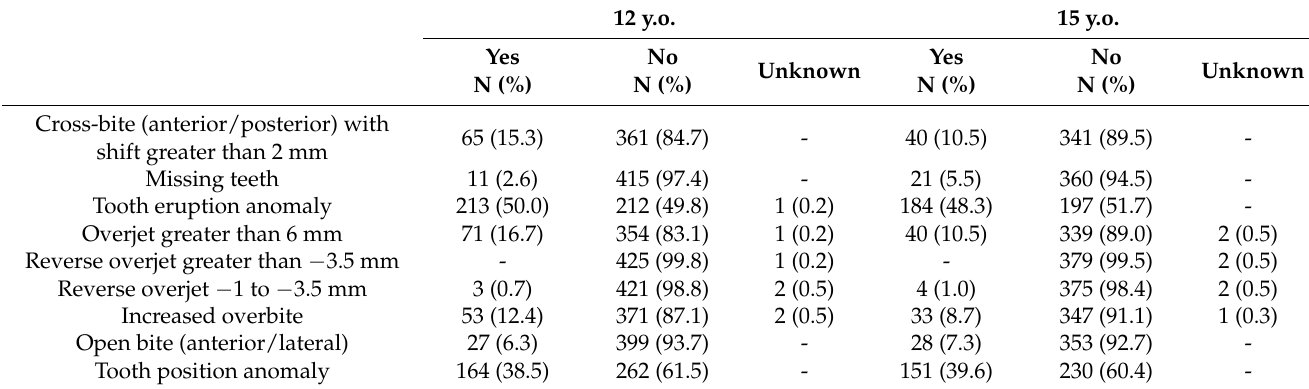
Table 8. Distribution of occlusal traits according to the modified IOTN among the 807 adolescents in need of orthodontic treatment. 12 y.o. 15 y.o.